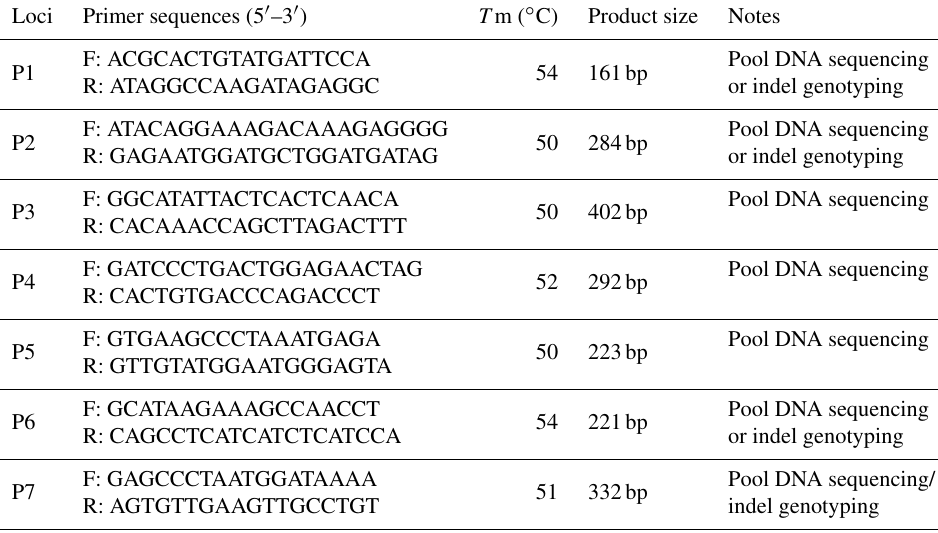
Table 1. Primers designed for detecting indels of MSRB3 gene in cattle. Loci Primer sequences (5 (cid:48) –3 (cid:48)